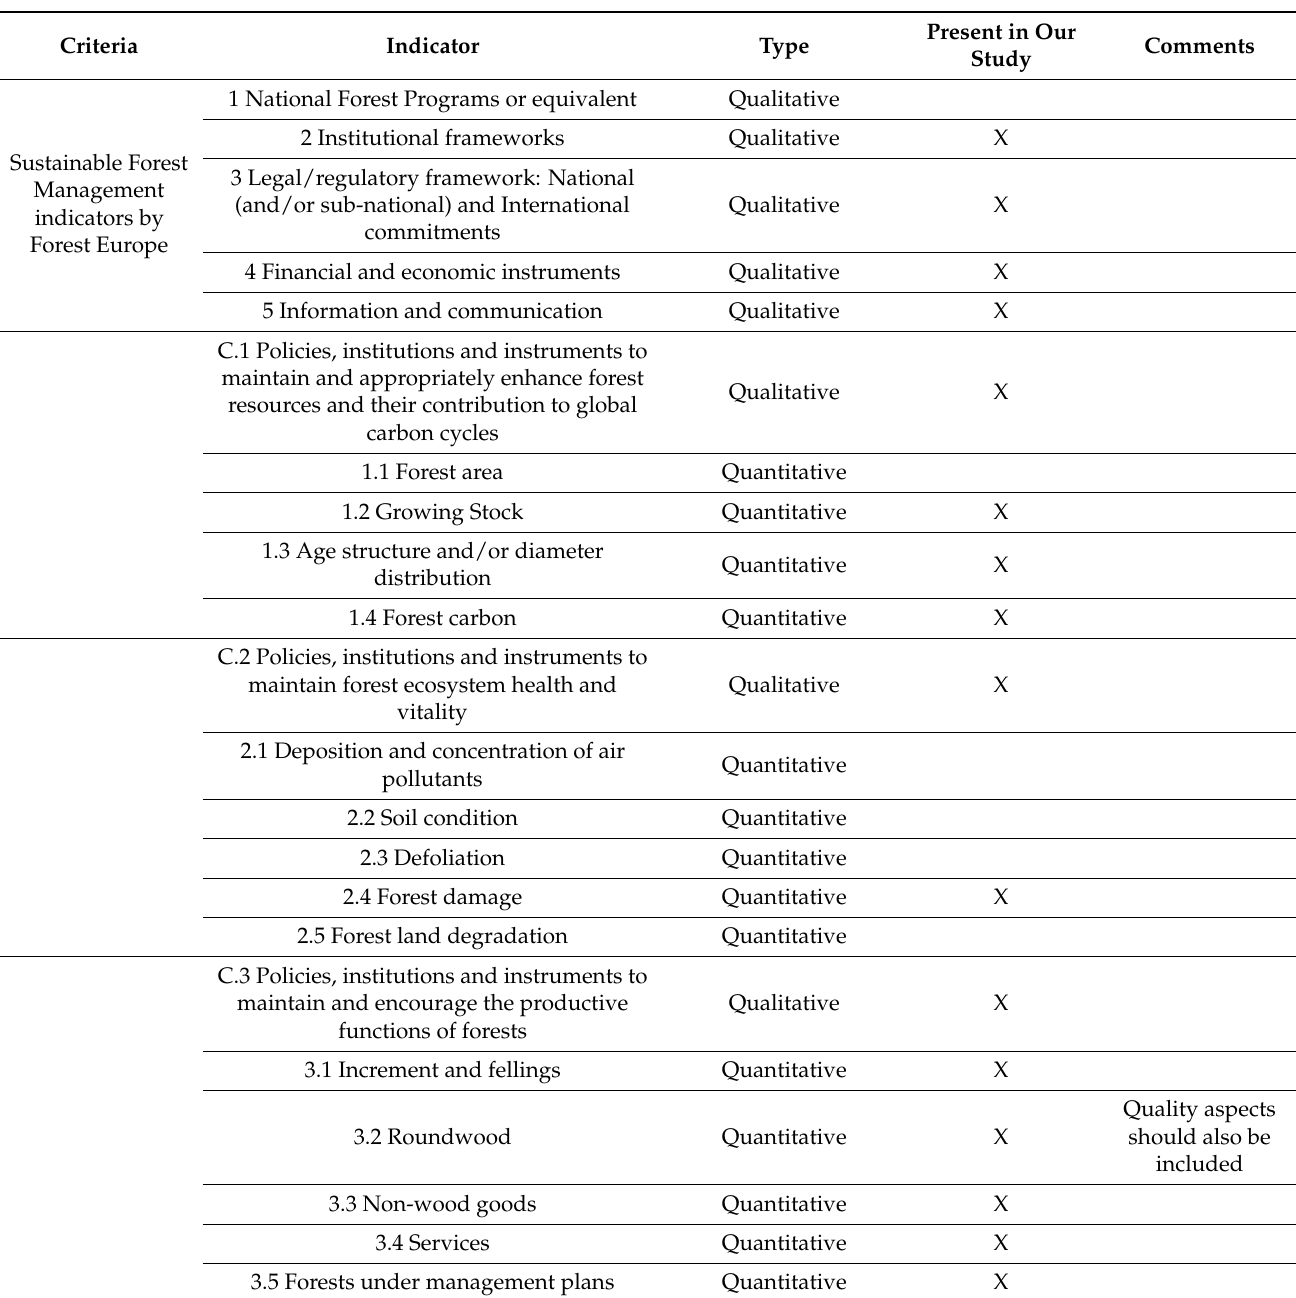
Table 3. Indicators for Climate-smart Forestry identified in our study, adapted from Forest Eu- rope’s Criteria and Indicators for Sustainable Forest Management (SFM) [48] with additions from Bowditch et al. [12] and our